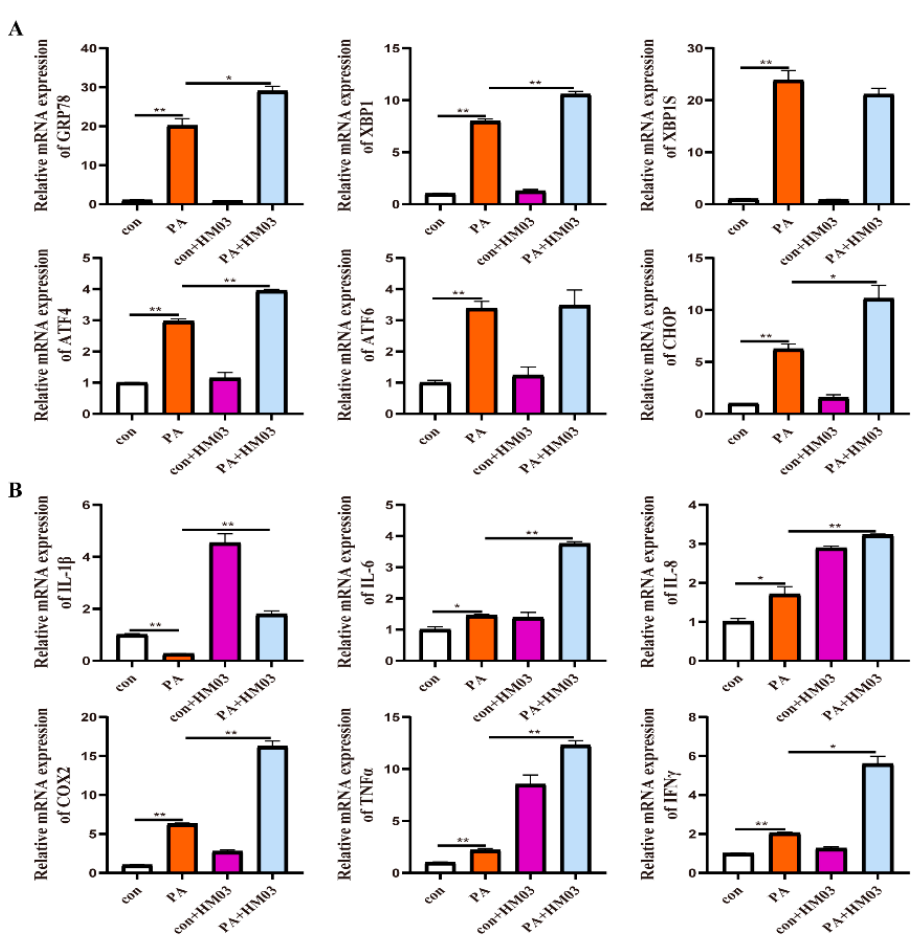
Figure 12. Effects of 10 µ M HM03 treatment for 4 h after 500 µ M PA incubation for 6 h on ER stress and inflammation in macrophages of large yellow croakers. ( A ) Relative mRNA expression of ER stress-related genes. ( B ) Relative mRNA expression of inflammatory genes. Values are presented as mean ± SEM ( n = 3). * Significant difference ( p < 0.05); ** highly significant difference ( p < 0.01).